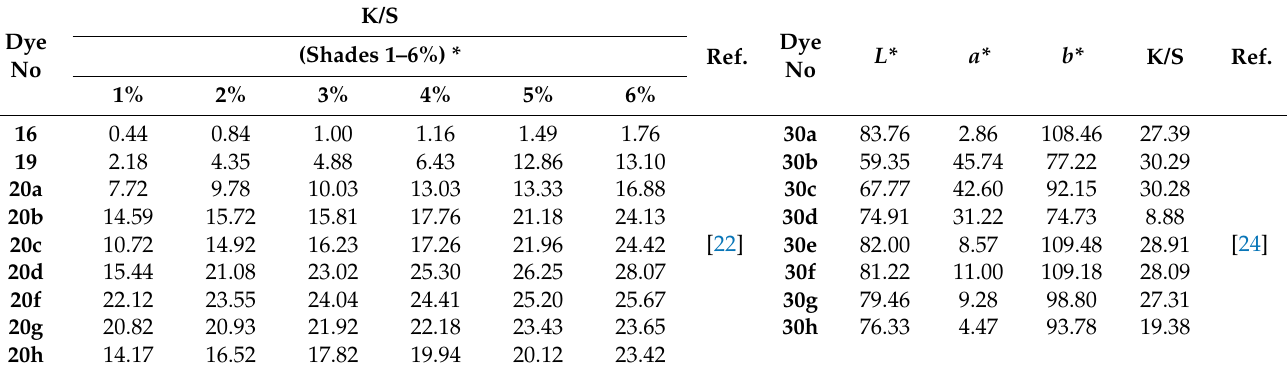
Table 4. K/S of dyes 16 , 19 , 20a – h and 30a – h